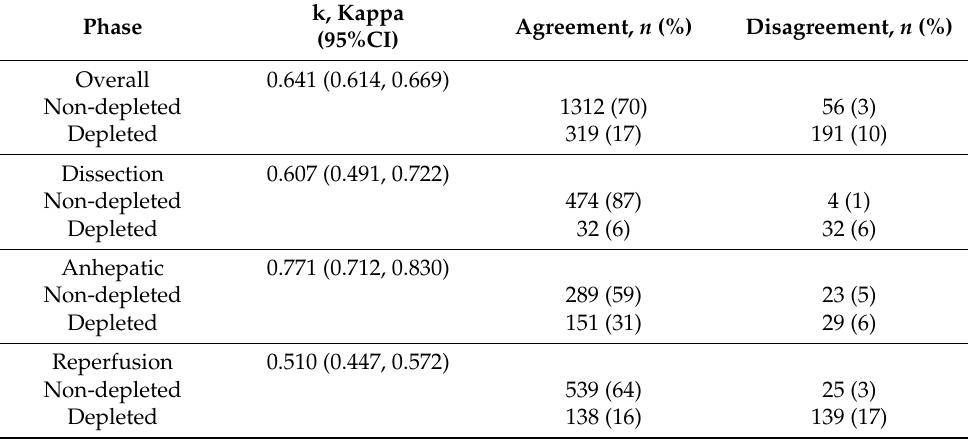
Table 2. Agreement regarding intravascular volume depletion between PPV-radial and PPV-femoral.